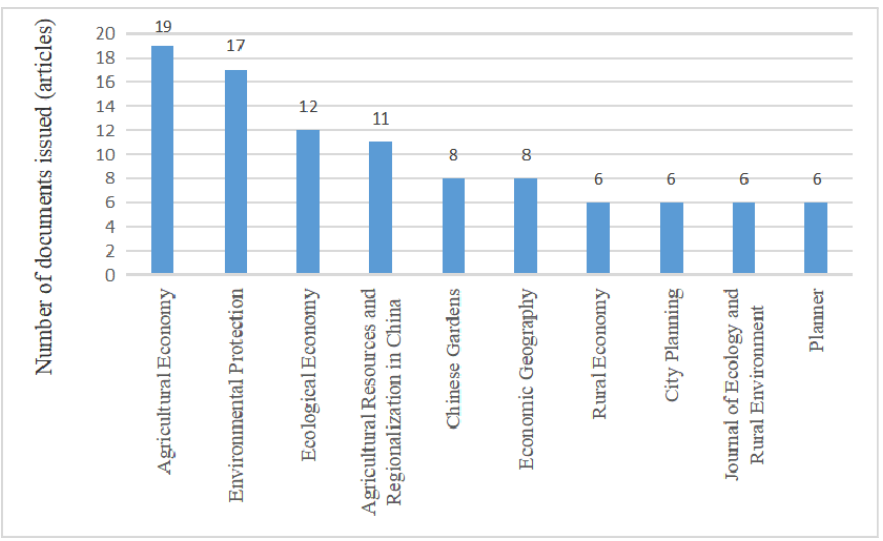
Figure 1. General trend in the literature on rural human settlement environments.